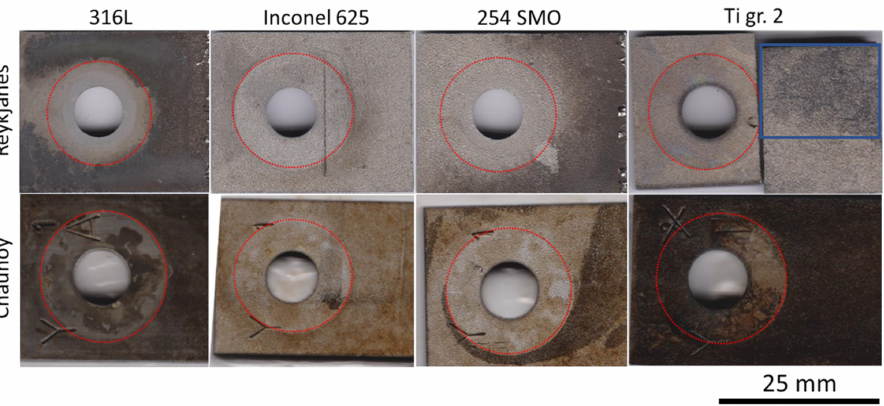
Figure 5. Coupons after exposure, the sample size is 25 mm in the vertical direction. The red circles indicate the covered areas, unexposed, due to ceramic shielding of the fastener. The blue square on the Ti gr. 2 sample exposed in Reykjanes marks the main affected area of the sample. The samples exposed in Reykjanes showed discoloration on all samples except the Inconel 625. The samples exposed in Chaunoy showed an indication of deposits from the fluid for all